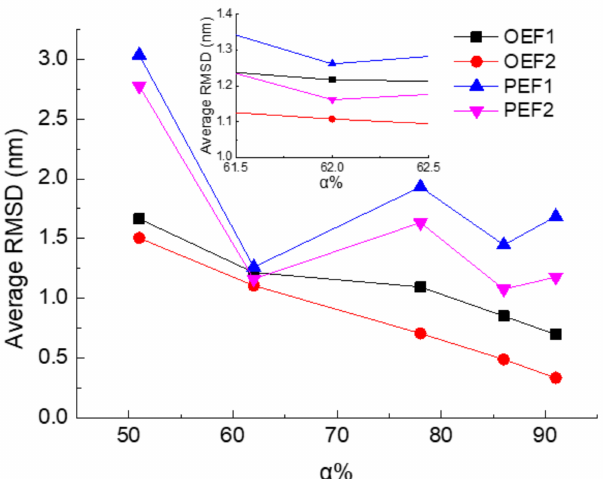
Figure 3. (Color online) The average value of RMSD versus the residual ratio of α -helix among protein